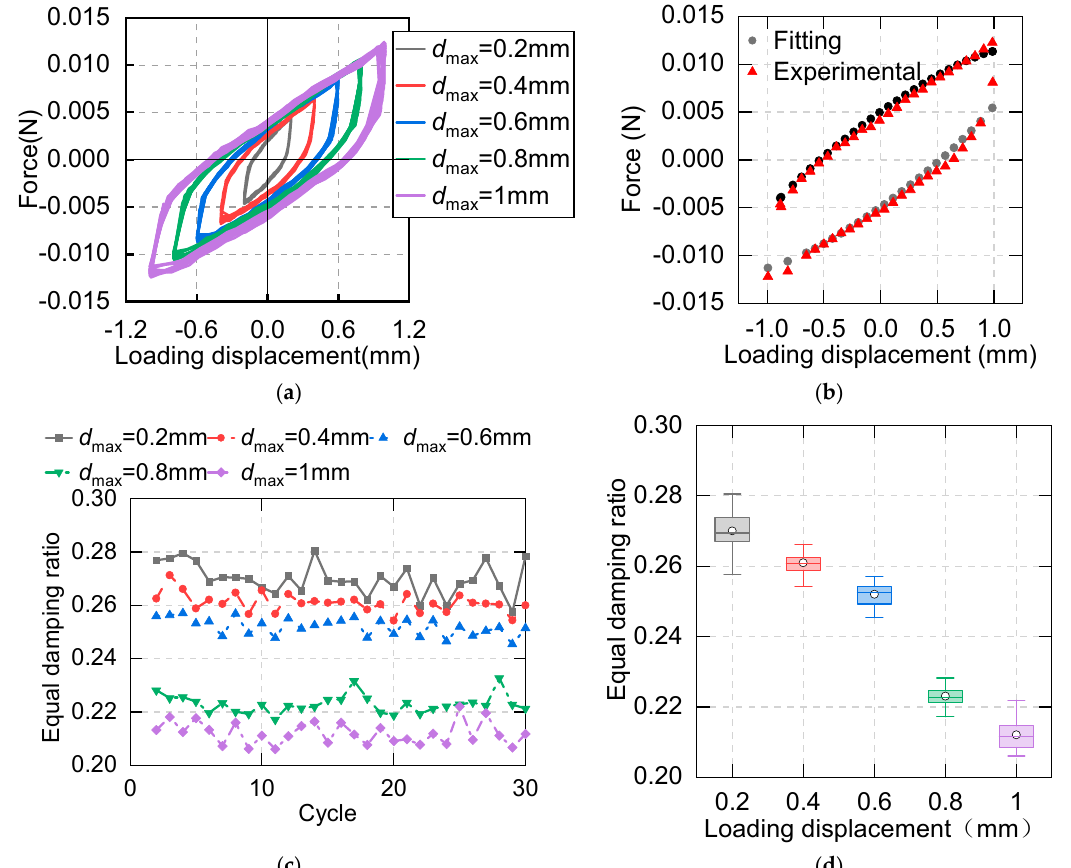
Figure 3. Variance curves of the damping properties for cyclic simple shear tests under repeated excitation at 20 °C: ( a ) hysteretic loops of repeated loadings under a frequency of 0.1 Hz, HCC mass ratio of 0.2, and displacement amplitudes of 0.2–1 mm; ( b ) the fitting results of the hysteretic curves; ( c ) the equivalent damping ratios of different conditions; ( d ) box chart of the damping ratio with different frequencies over 30 cycles.